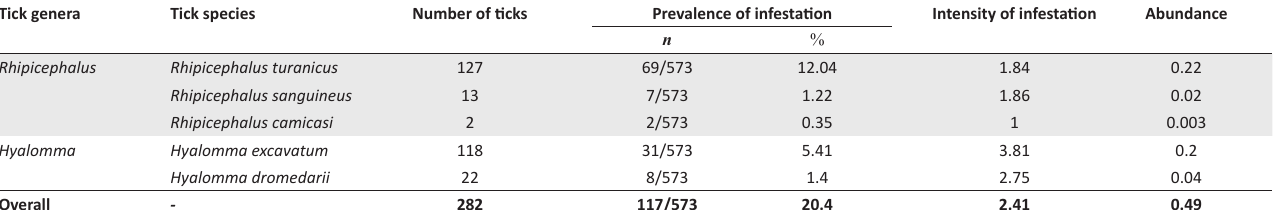
TABLE 2: Tick infestation